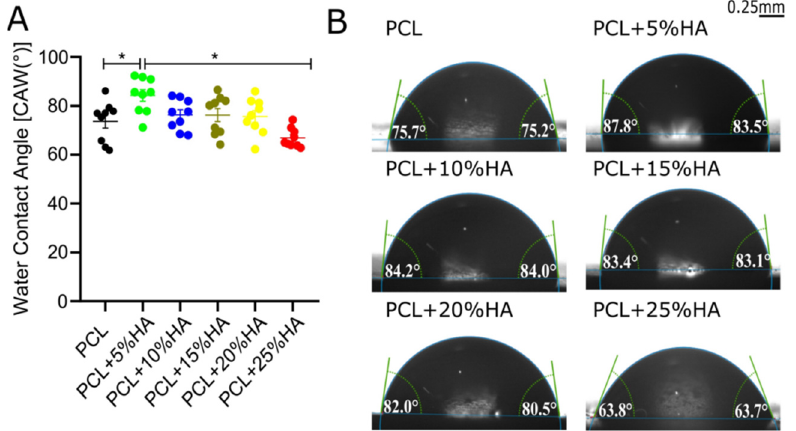
Figure 5. Water contact angle test. ( A ) Graph represents the water contact angle, mean ± s.e.m, * = p < 0.05 (one-way ANOVA + Tukey’s post hoc test ( n = 9). ( B ) Images of water contact measurements for each group left and right side: scale bar = 0.25 mm.